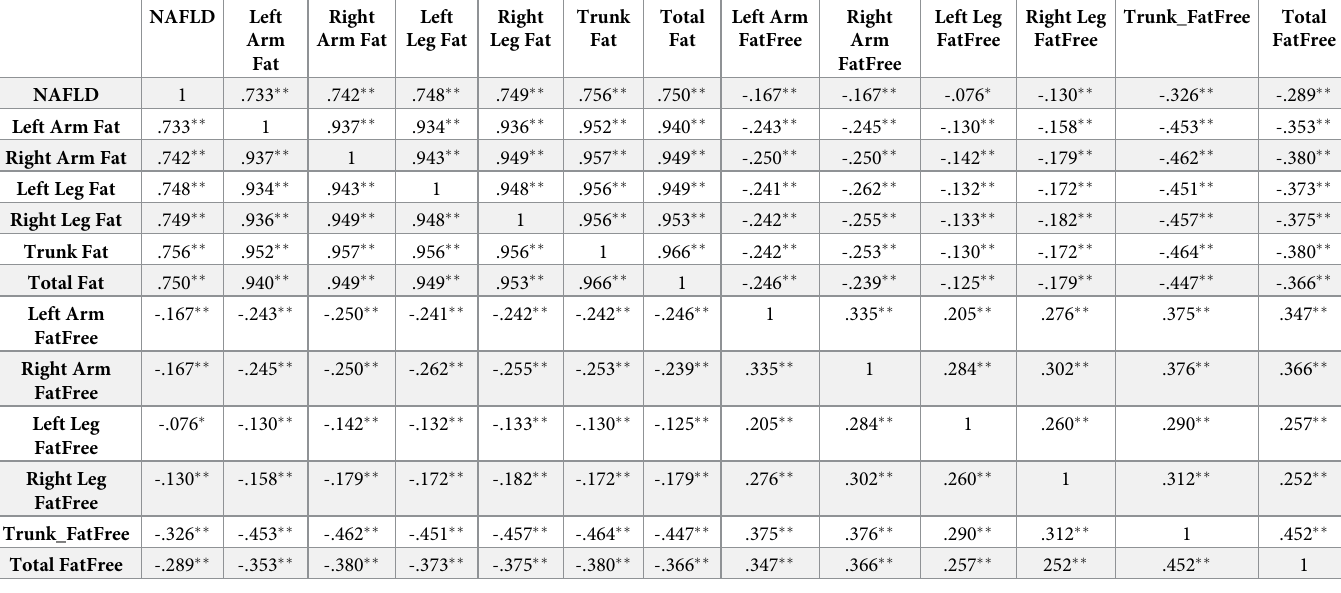
Table 2. Correlation # of fatty liver by body composition in